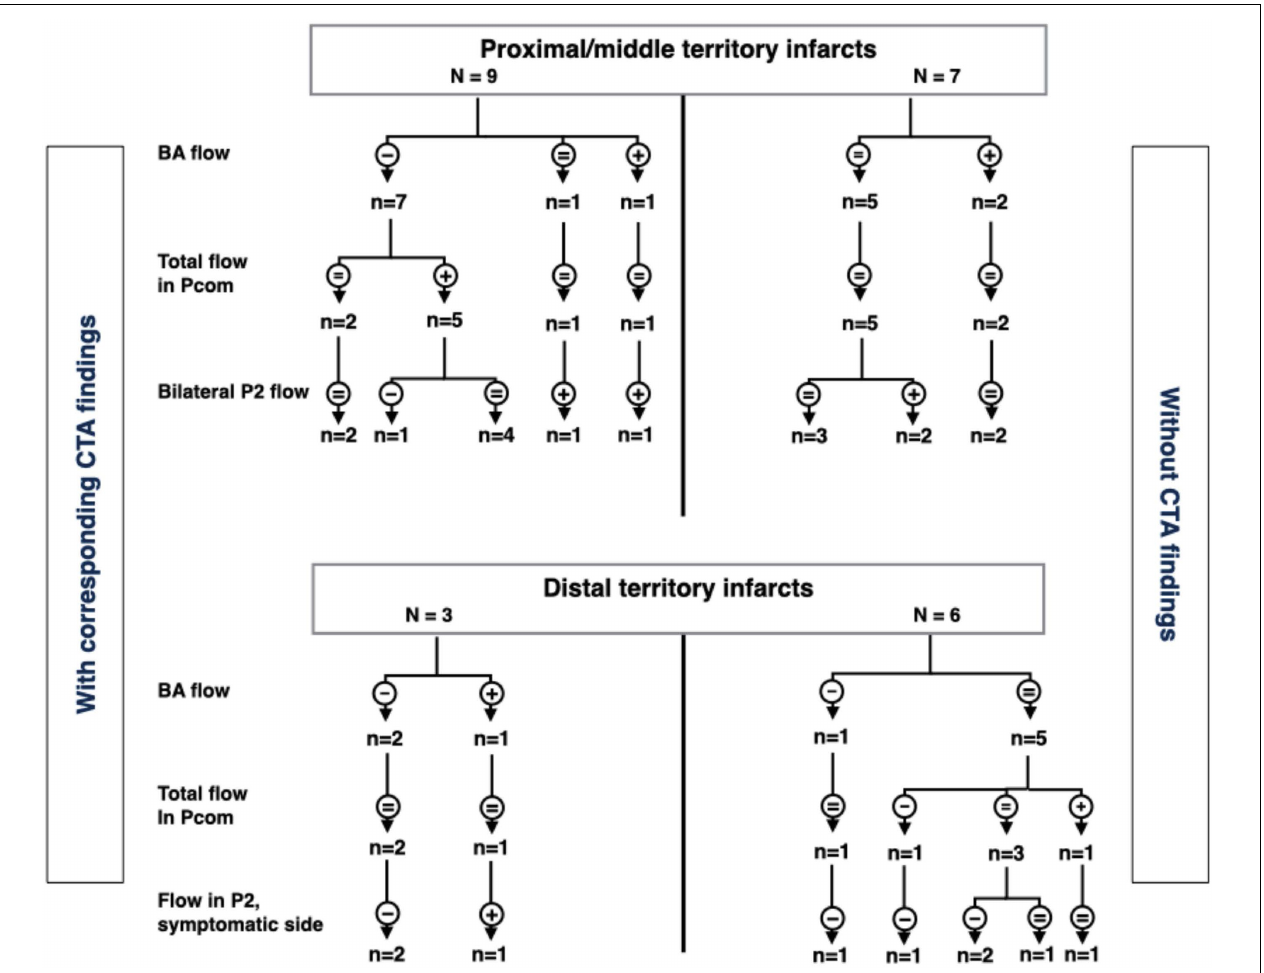
FIGURE 5 | Summary of arterial flow in patients with proximal/middle territory or distal territory infarcts. CTA stenoses/occlusions are on left and right sides, respectively. The flowchart is based on flow in the basilar artery, posterior communicating arteries, and distal parts of the posterior cerebral arteries (P2). -, low flow; +, high flow; =, flow within normal limits; VA, vertebral arteries; Pcom, posterior communicating arteries; P2, second segment of posterior cerebral artery; CTA, computed tomography